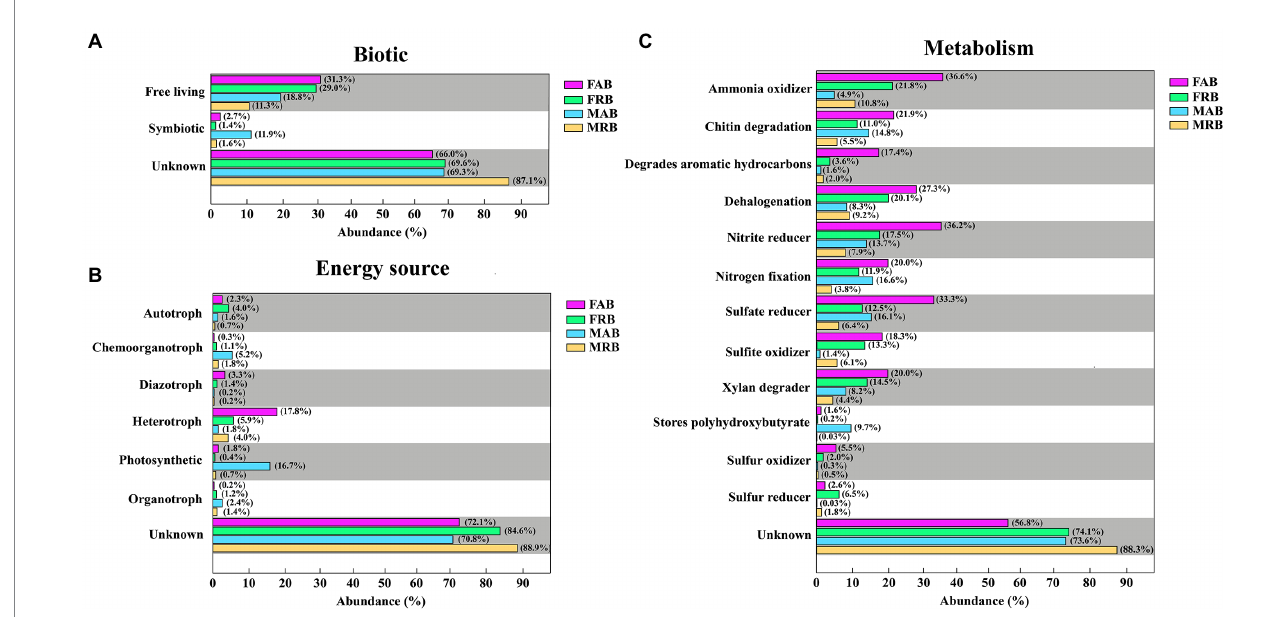
FIGURE 8 The potential phenotypic characteristics and metabolic functions of abundant and rare bacteria in the fruiting body and mycosphere. (A) Potential metabolism of abundant and rare bacteria in the fruiting bodies and mycosphere. (B) Energy sources of abundant and rare bacteria in the fruiting bodies and mycosphere. (C) Biological relationships between abundant and rare bacteria in the fruiting bodies and mycosphere. FAB, abundant bacteria of the fruiting bodies; FRB, rare bacteria of the fruiting bodies; MAB, abundant bacteria of the mycosphere; MRB, rare bacteria of the